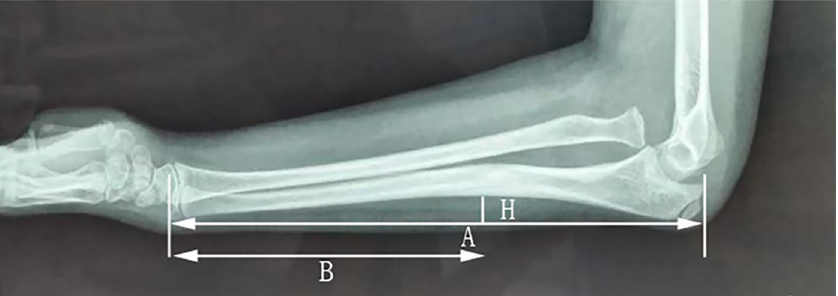
Figure 1. A line is drawn from the olecranon to the metaphysis of the distal end of the ulna. The maximum vertical distance from the straight line to the dorsal edge of the ulna is the maximum arcuate distance of the ulna and is recorded as MUB (H), A is the distance from the olecranon to the epiphysis of the distal ulna, and B is the distance from the position of the maximum arcuate sign to the epiphysis of the distal ulna. The maximum